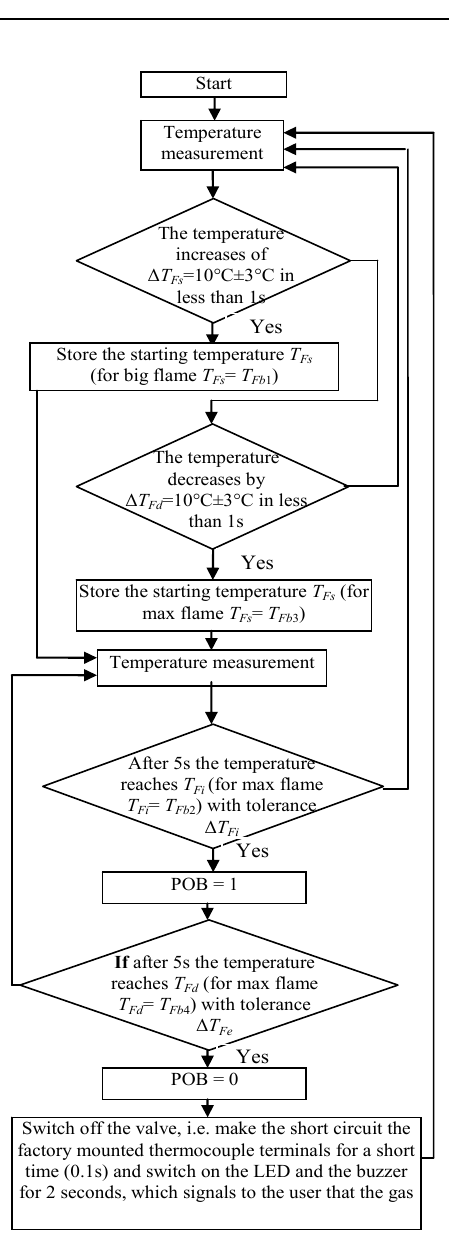
Figure 9. Temperature changes measured by linear thermocouple located in position 3.